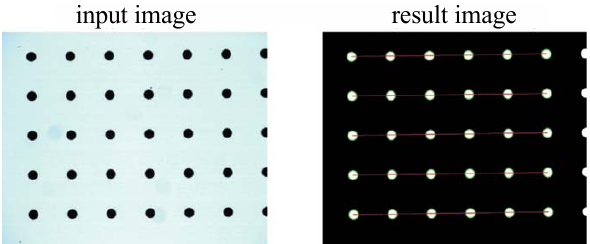
Fig. 5: The scaling factor is obtained by comparing the detected pattern with known physical 2 Figure 5. The scaling factor is obtained by comparing the detected features (center point distances). 3 pattern with known physical features (center point 4